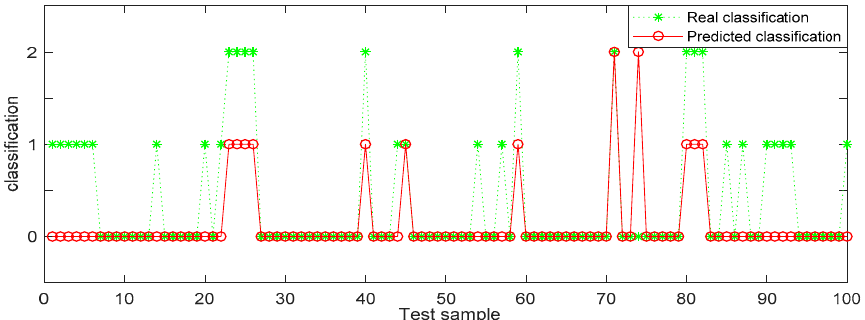
Figure 9. Random forest identification results from dataset 2.